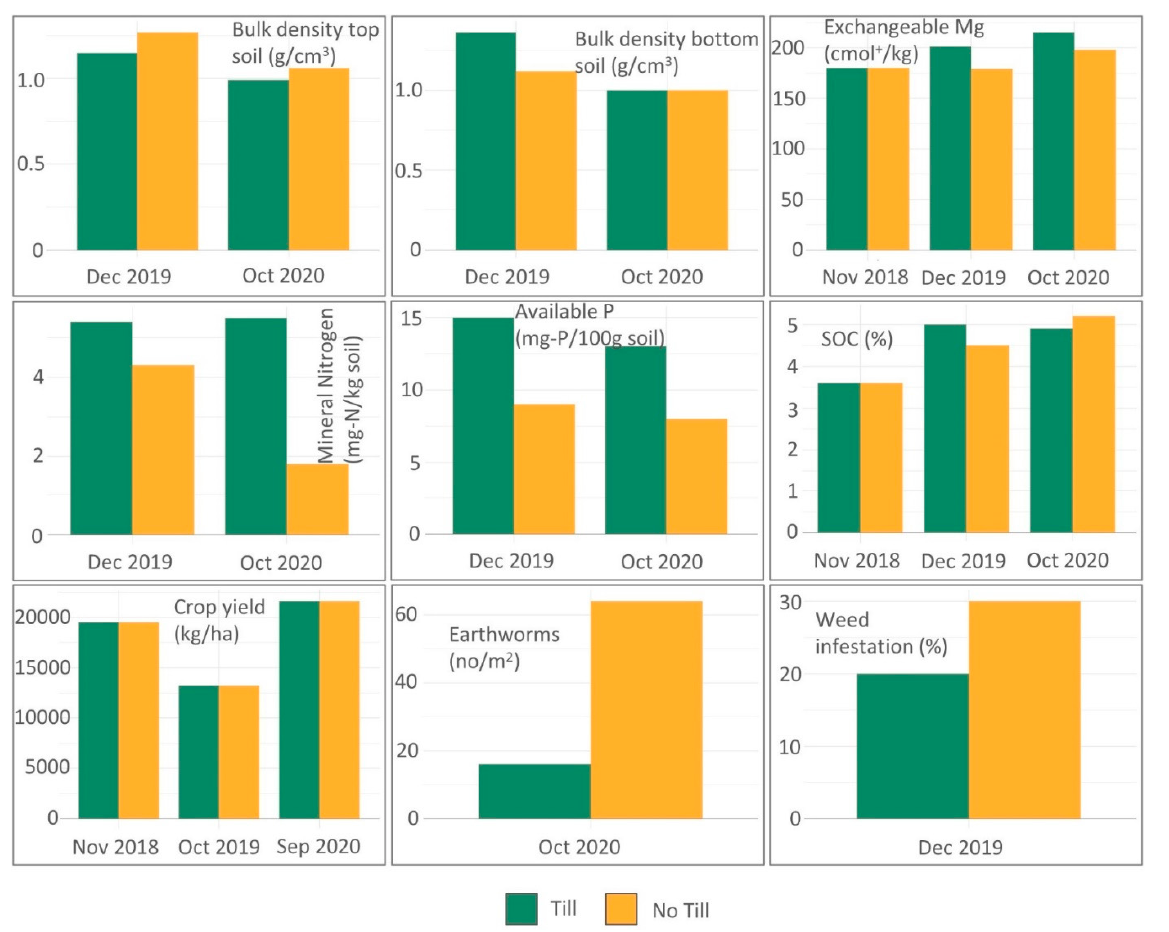
Figure 5. Soil properties in tilled and non-tilled plot at the olive orchard site during the 2.5-year monitoring.